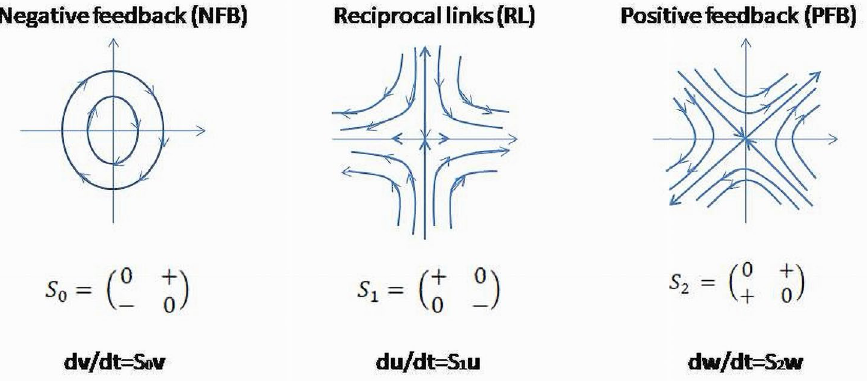
Figure 6. Sketch of dynamical images of NFB, RL and PFB patterns as phase curves of ODE. Matrices of NFB, PFB and RL determine the character of phase curves of ODE. Variables are expressed in a vector form { S 0 , S 1 , S 2 } represents basis elements of a Lie algebra sl ( 2, R ) of traceless matrices and imaginary basis elements of coquaternions .